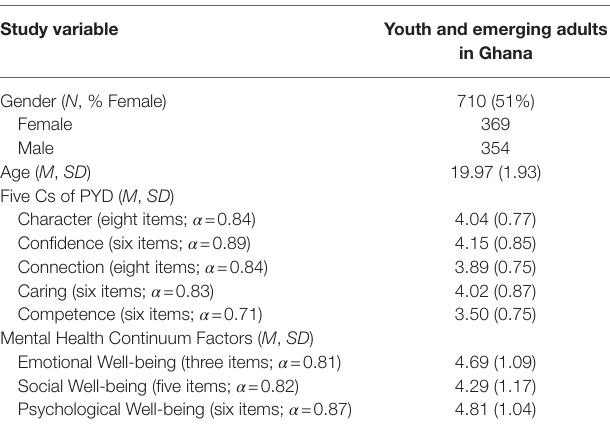
TABLE 1 | Demographic and descriptive information for the study variables among youth and emerging adults in Ghana. Study variable Youth and emerging adults